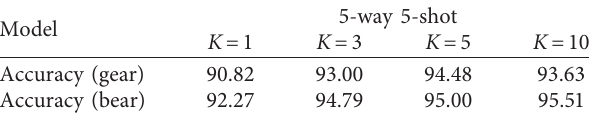
Table 6: Results of experiment with different K .